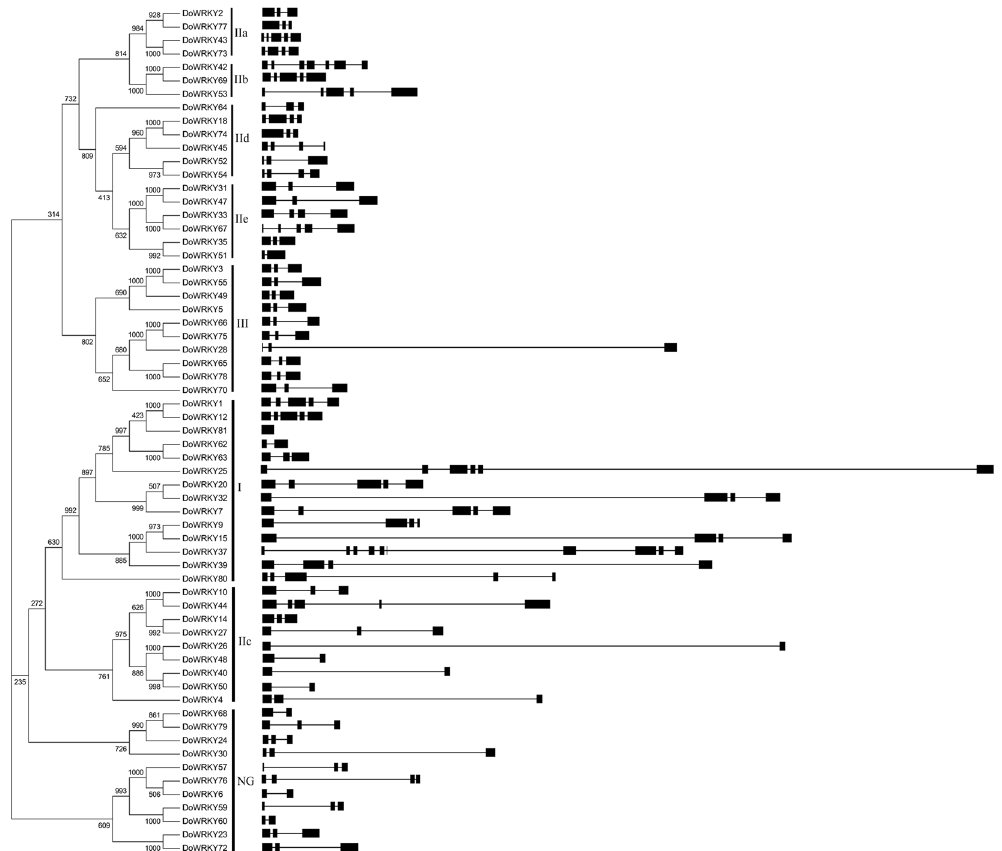
Figure 3. Phylogenetic analysis and structures of WRKY genes in D. officinale . The phylogenetic tree was constructed by ClustalX 2.0 with the Neighbor–Joining method and 1000 bootstrap replicates based on alignments of complete predicted DoWRKY protein sequences. In the gene structure diagram, black boxes and lines represent exons and introns,